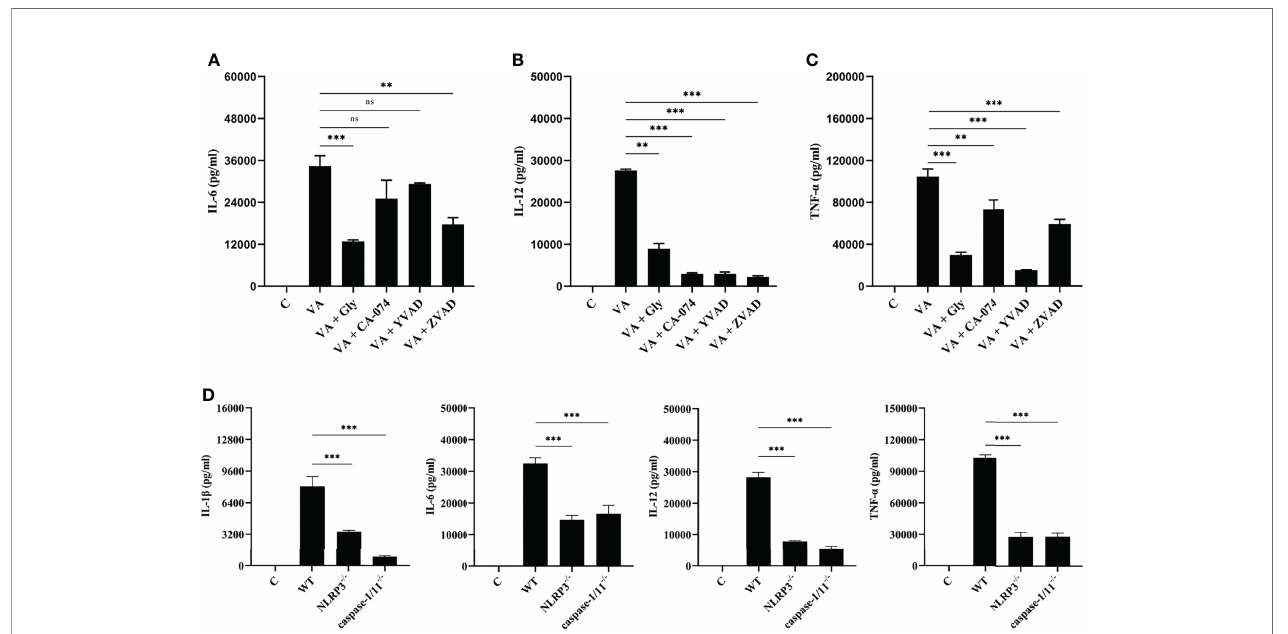
FIGURE 5 | Activation of NLRP3 in fl ammasome positively regulated V. alginolyticus -mediated in fl ammatory response. (A – C) Mouse peritoneal macrophages were pretreated with 50 m M glyburide, 25 m M CA-074 methyl ester, 100 m M Ac-YVAD-CHO, or 10 m M Z-VAD-FMK for 1 h prior to V. alginolyticus infection under conditions of MOI = 1/12 h. The protein expressions of IL-6, IL-12 and TNF- a were measured by ELISA. (D) The WT, NLRP3 -/- , and caspase-1/11 -/- mouse peritoneal macrophages were simulated by V. alginolyticus under conditions of MOI = 1/12 h. The protein expressions of IL-1 b , IL-6, IL-12, and TNF- a were measured by ELISA. Data from ELISA assays were representative of at least three repetitive experiments. ns, not signi fi cance, ** p < 0.01 and *** p <